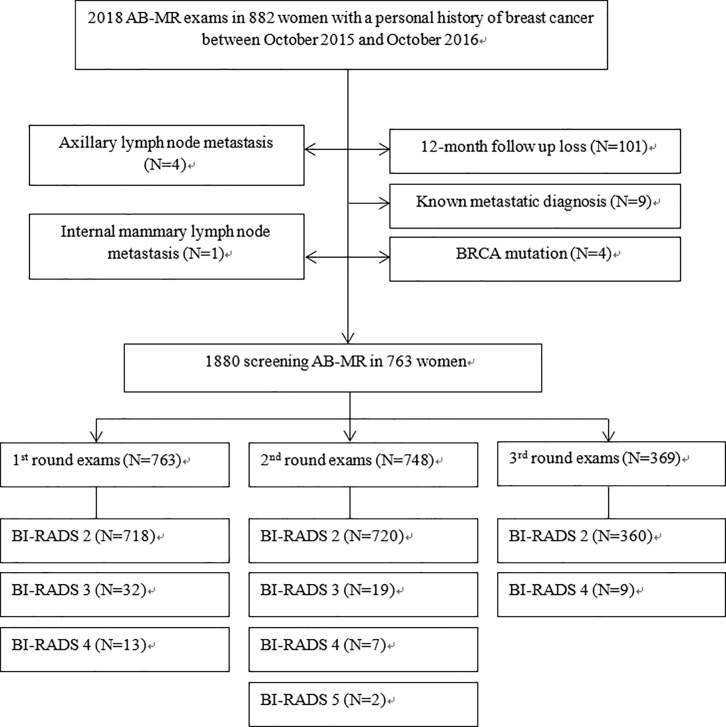
Study population.